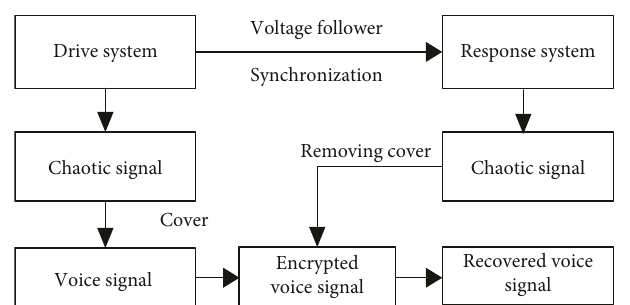
Figure 20: The switching encryption circuit.